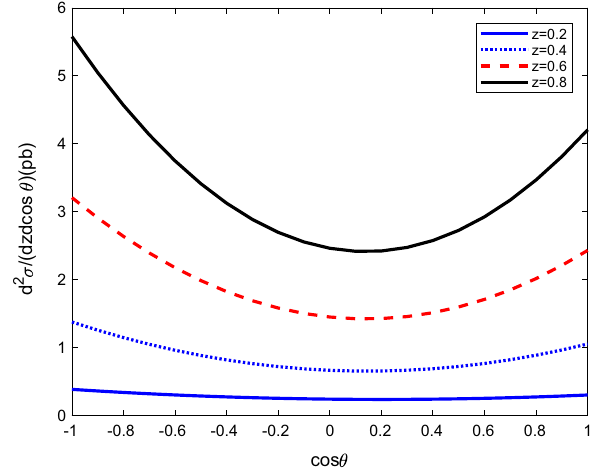
Fig. 4 The differential cross section d 2 σ/( dz d cos θ) for the produc- tion of the B ∗ c ( 2 3 S 1 ) meson at the Z pole under the fragmentation- function approach up to NLO+NLL level, where θ is the angle between the momenta of the final B ∗ c ( 2 3 S 1 ) meson and the initial electron